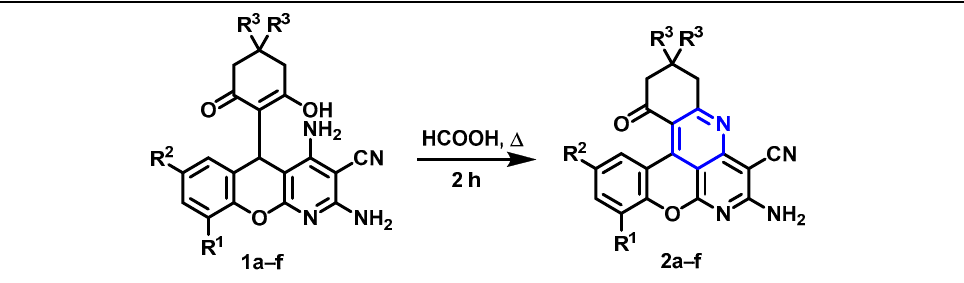
Table 2. Intramolecular oxidative cyclization of 5 H -chromeno[2,3- b ]pyridines 1a – f 1